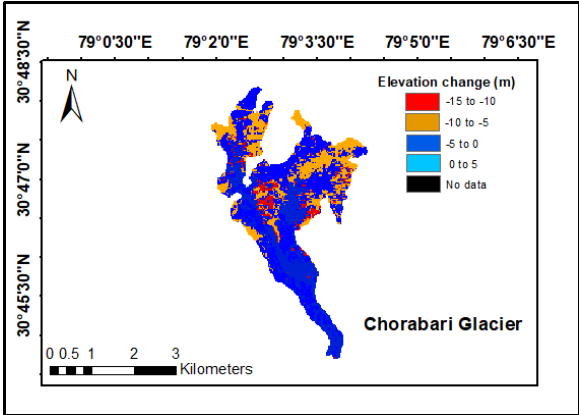
Figure 3. Elevation change for Chorabari glacier from